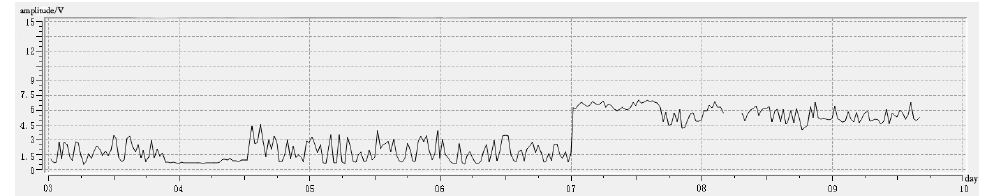
Figure 4. MNLG low-frequency electromagnetic